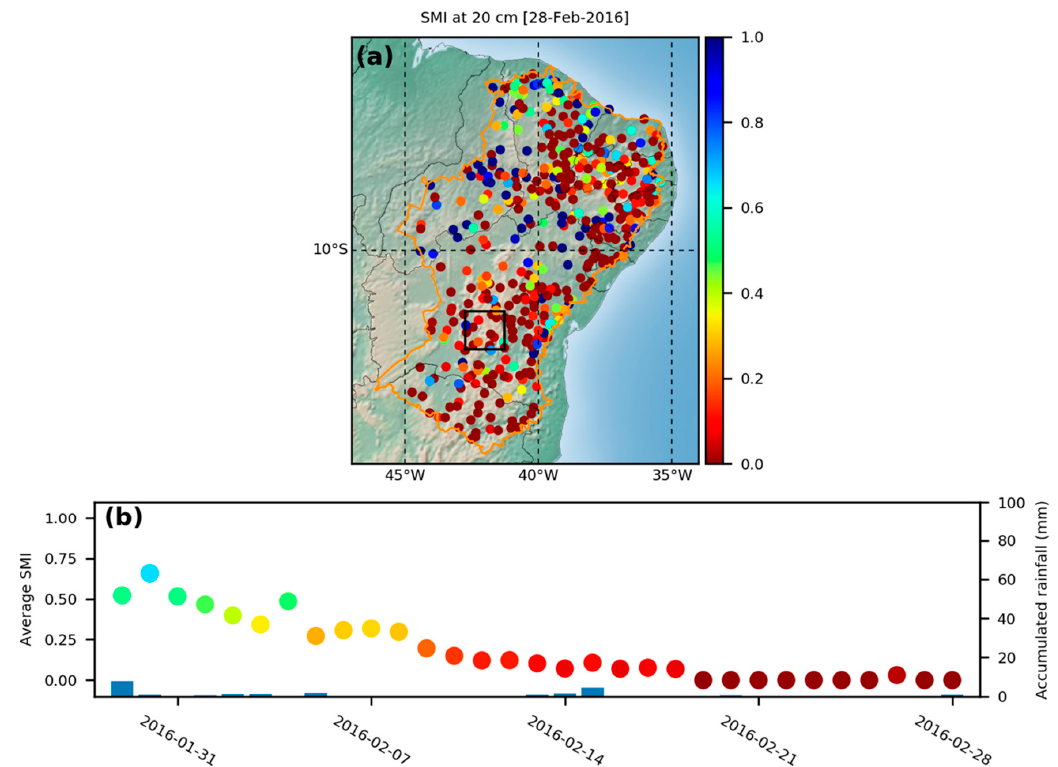
Figure 8. ( a ) SMI for 28 February 2016; and ( b ) left axis : average SMI over the stations inside the square during the last 30 days; and right axis : daily accumulated rainfall.